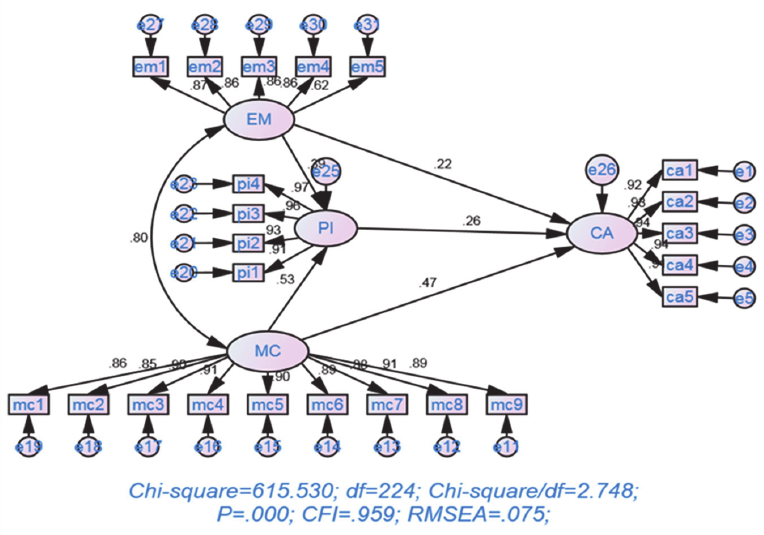
Fig. 3. Findings from SEM